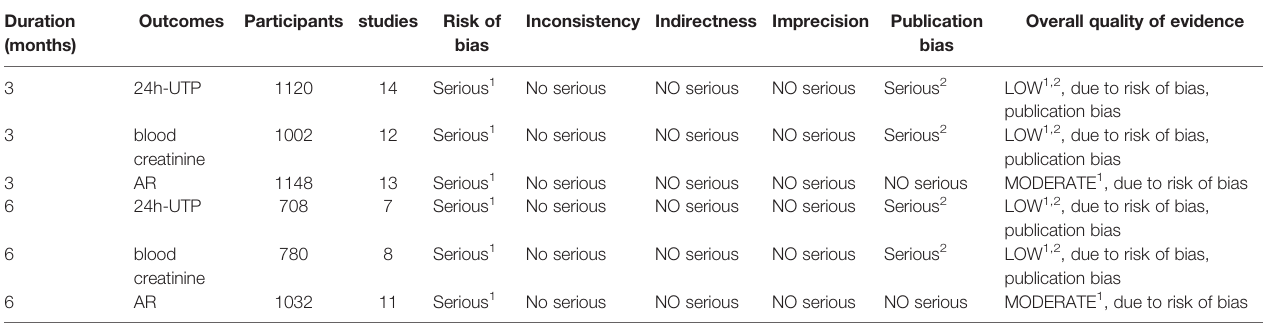
TABLE 4 | GRADE assessment of quality of evidence for outcomes. Duration (months)